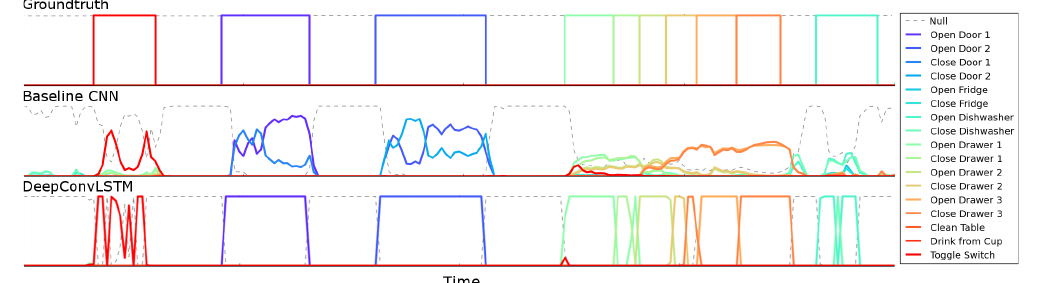
Figure 6. Output class probabilities for a ~25 s-long fragment of sensor signals in the test set of the OPPORTUNITY dataset, which comprises 10 annotated gestures. Each point in the plot represents the class probabilities obtained from processing the data within a sequence of 500 ms obtained from a sliding window ending at that point. The dashed line represents the Null class. DeepConvLSTM offers a better performance identifying the start and ending of